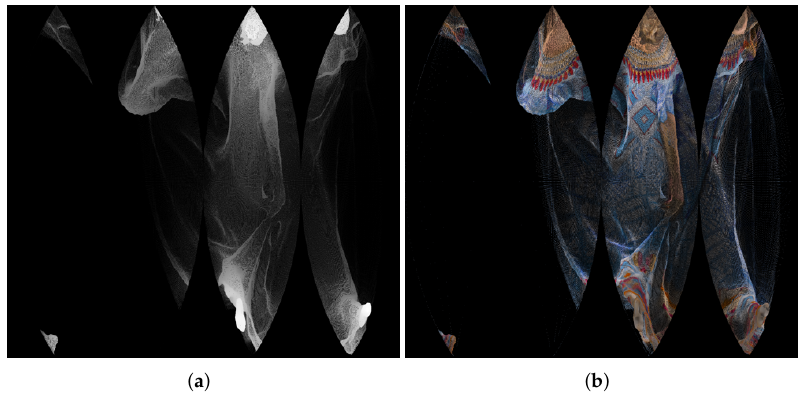
Figure 10. Panorama images created using point cloud “longdress_vox10_1060.ply” from the stereo- graphic projection, for the geometry ( a ) and texture ( b